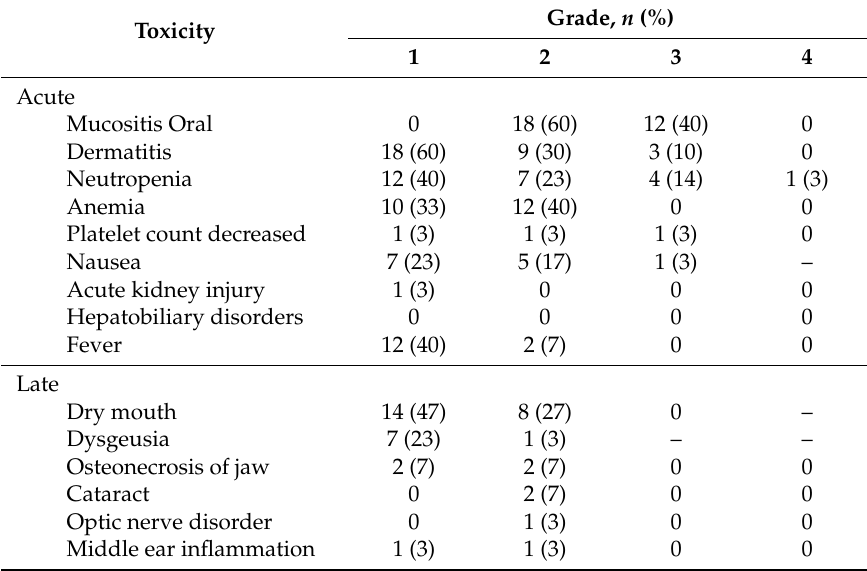
Table 3. Adverse events (NCI-CTCAE v.4.0) 1